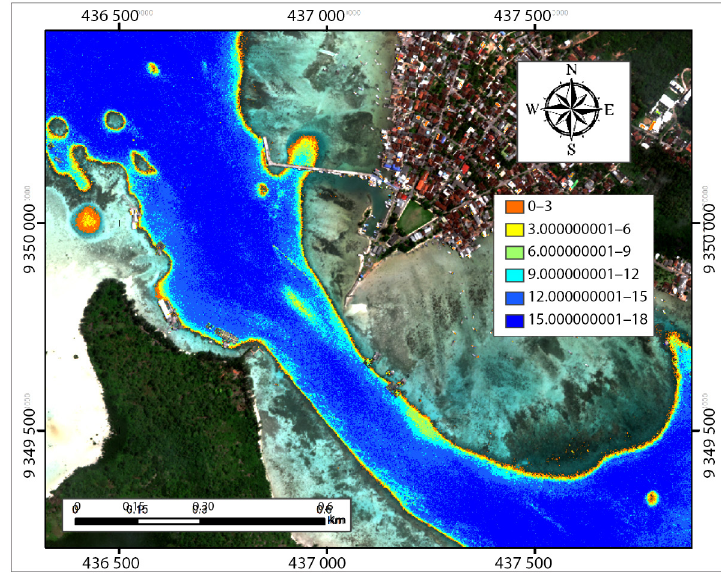
Figure 6. Bathymetry map retrieved from Worldview-3 in Karimun